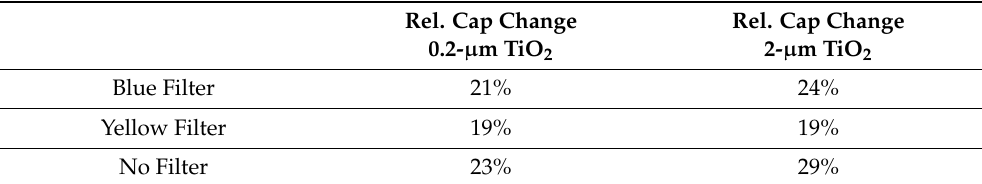
Table 2. Relative capacitive change using C-V measurements in a 3-electrode setting when illuminated by a 300 W white-light source.